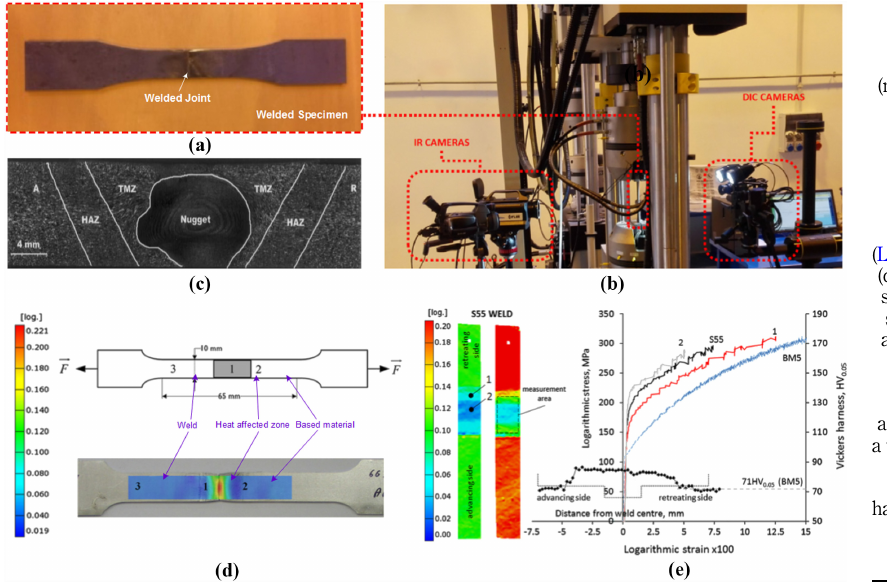
Figure 7. (a) Welded specimen and (b) experimental setup of the measurement system (Corigliano et al. , 2017); (c) the microstructure corresponding to the friction stir welding, where thermo- mechanically affected zone (TMZ), heat affected zone (HAZ) and fine